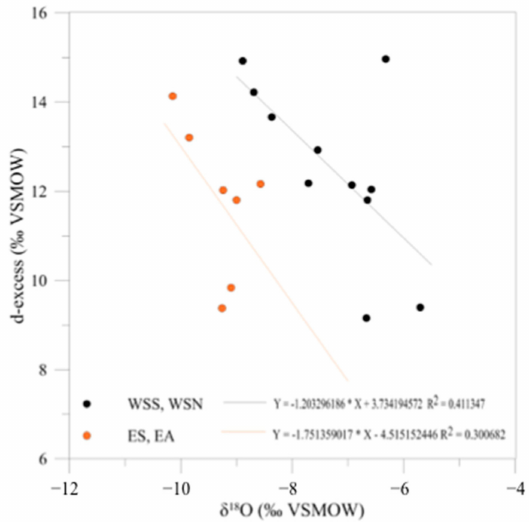
Figure 8. Plot of the deuterium excess versus oxygen-18 for springs belonging to the western (WSS and WSN) and eastern side (ES and EA) of the studied